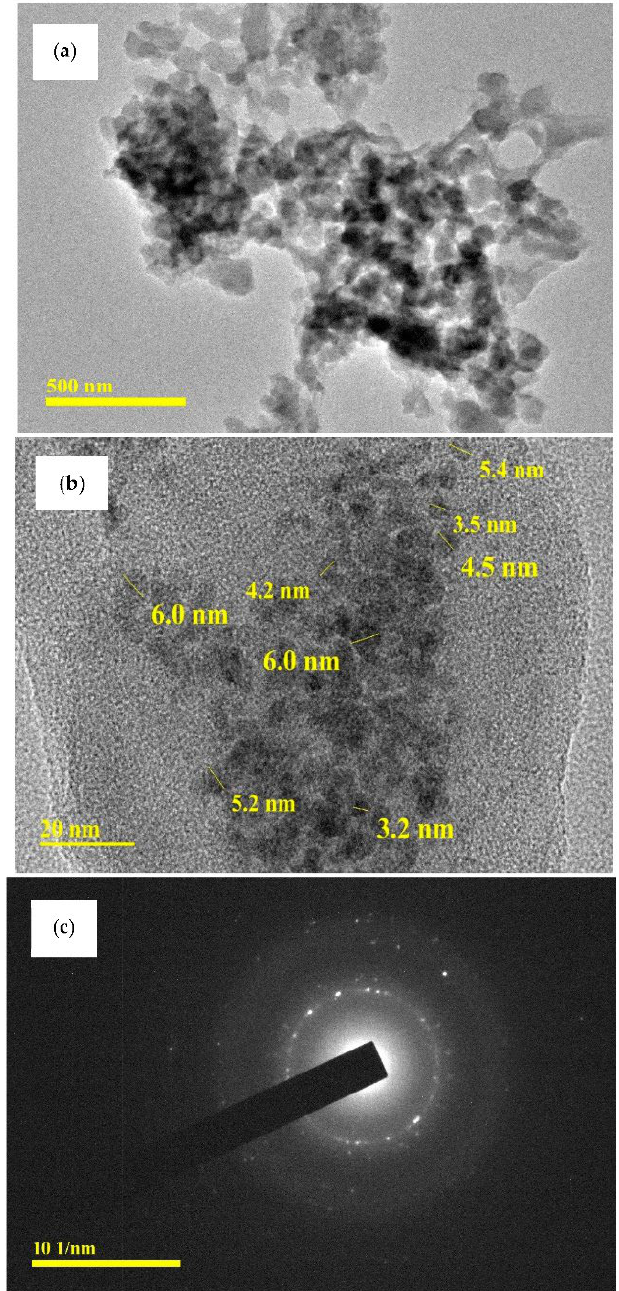
Figure 8. ( a , b ) TEM micrographs of CHT-CuO nanocomposite at different magnifications and ( c ) SAED pattern.